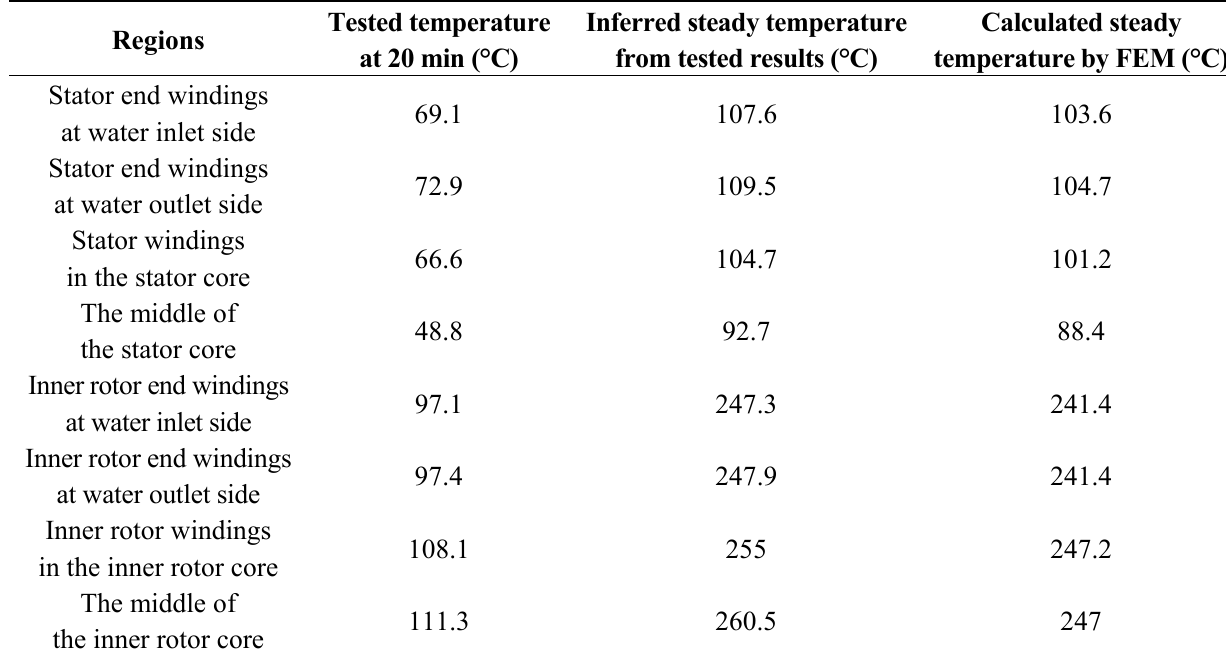
Table 13. Calculated and tested temperatures in the prototype when the SM and DRM run at rated torque and rated speed, and only water cooling is used in the casing. FEM: finite-element method.